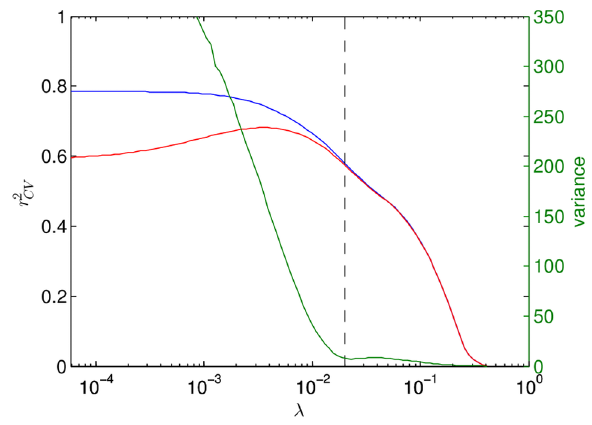
Figure 7. The LASSO solution of the quadratic model was computed for 100 values of l . Blue is the r 2 value, and red is the 10- . The green curve is the variance of f ( y ) for fold cross-validated r 2 CV randomly generated sequences. The variance is too large even for values of l that are larger than the optimal value predicted by the curve. We choose the model with l ~ 0 : 021 maximum of the r 2 CV (dashed line) for further analysis. This model has * 10 3 non-zero coefficients, most of which are epistatic.